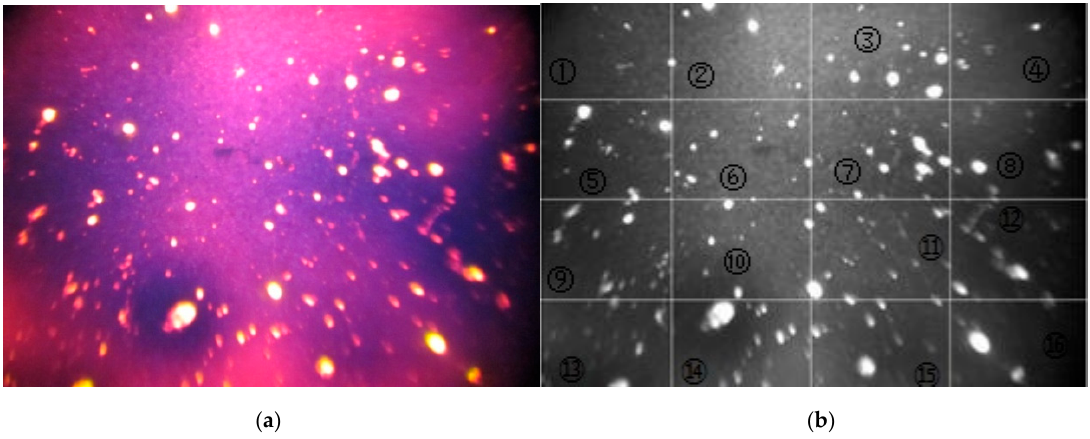
Figure 7. FM image of CWRP modified asphalt binder: ( a ) FM image and ( b ) gridded FM image.